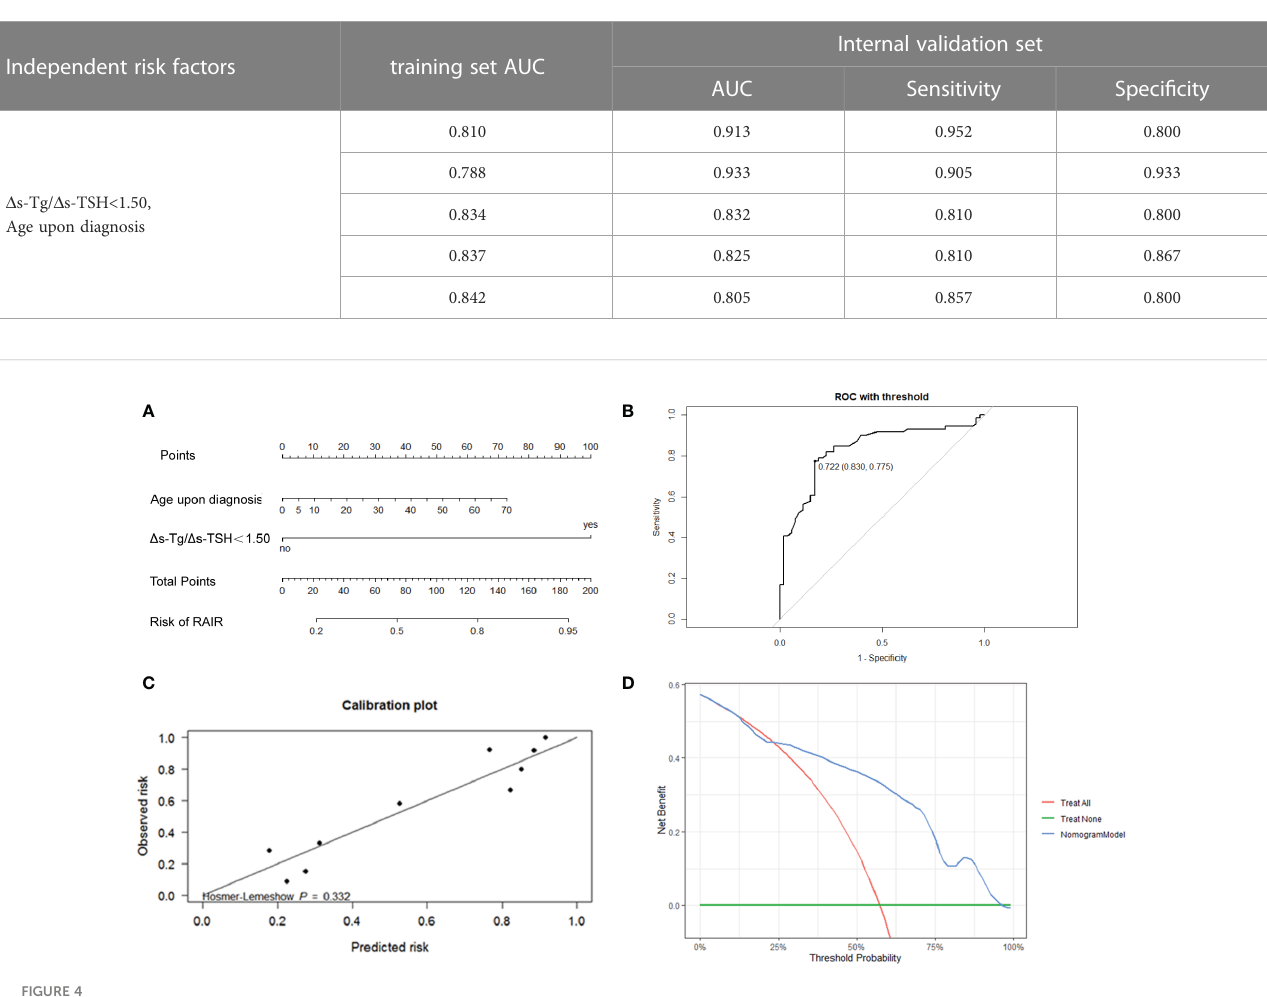
TABLE 3 Results of stepwise multivariate logistic regression on fi ve random samples. Independent risk factors training set AUC